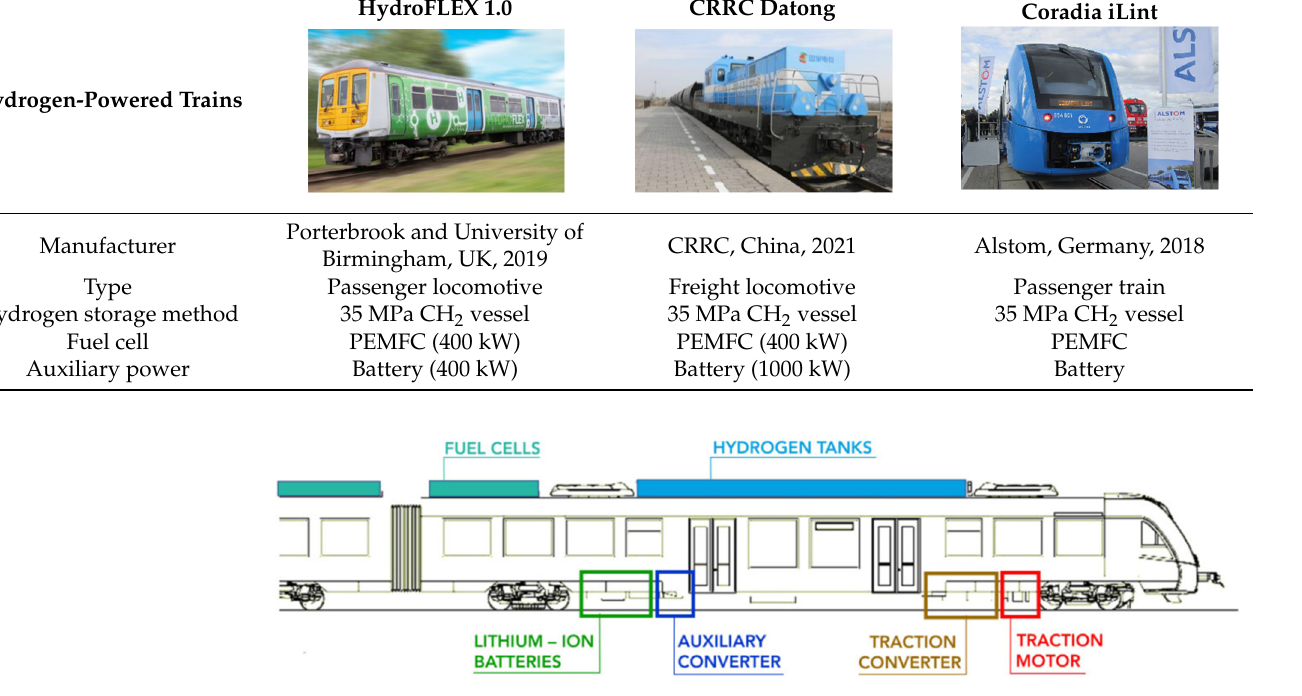
Figure 2. Diagram of Coradia ilint train, Alstom, propulsion system [49].